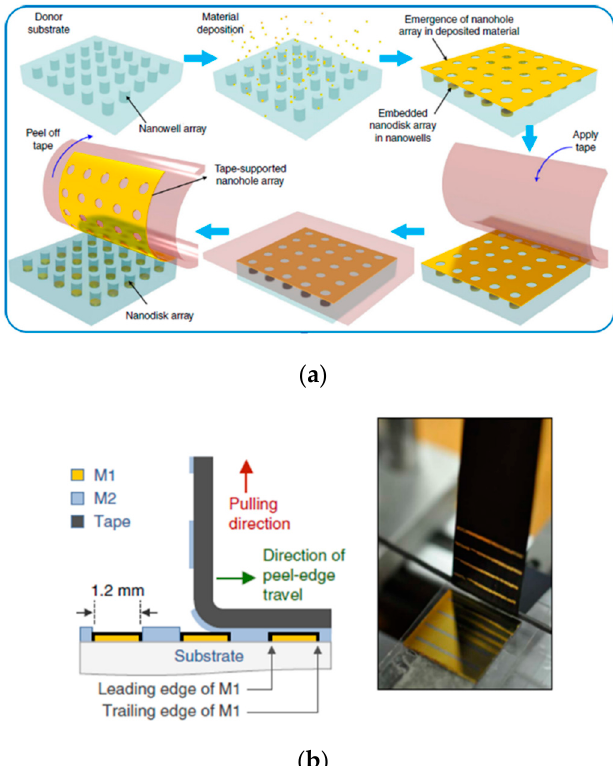
Figure 1. Adhesion or tape lithography. ( a ) Transfer of a nanopatterned film (Au nanohole array) to the surface of an adhesive tape. Reproduced from [22] under a Creative Commons Attribution 4.0 International License (http://creativecommons.org/licenses/by/4.0/). ( b ) Left: Schematics of selective nanostructured metal stripping by a pressure sensitive adhesive (PSA) tape. M1 and M2 stand for metal 1 and metal 2, respectively. Right: Photograph showing the tape after peeling; removed gold (M2) is visible on the adhesive side of the tape. Reproduced from [20] under a Creative Commons